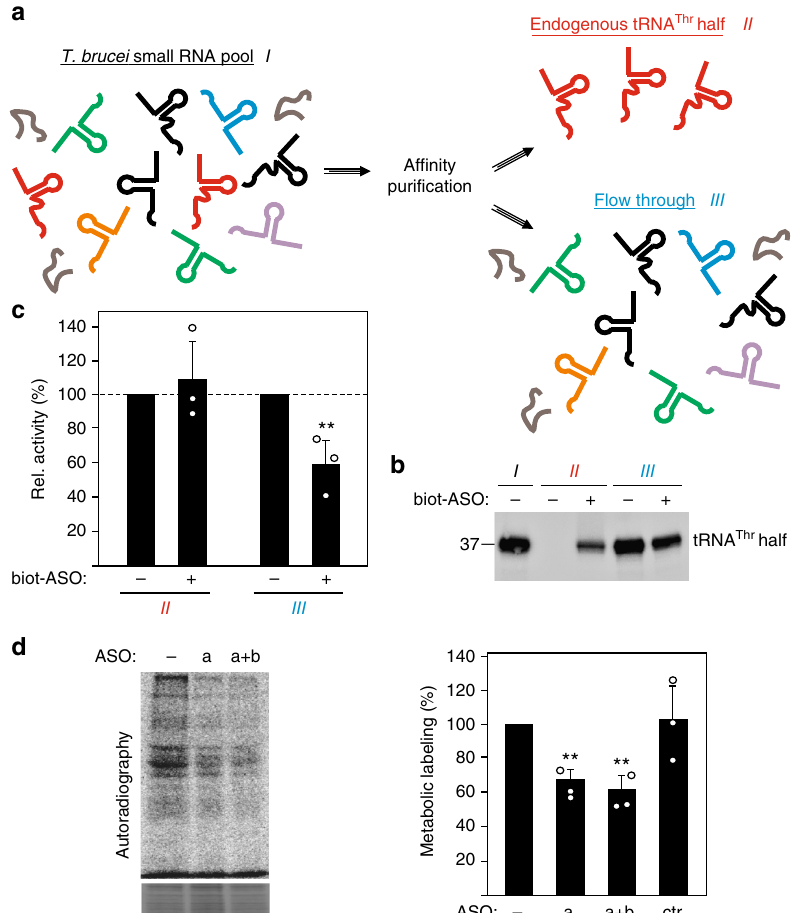
Fig. 6 Depletion of endogenous tRNA Thr 3 ′ halves alleviates the stimulatory effects during translation. a Scheme of the strategy used for af fi nity puri fi cation of the endogenous tRNA Thr 3 ′ half from the pool of small RNAs (size range between 30 – 40 nucleotides). As a control the same procedure was performed in the absence of a biotinylated antisense oligonucleotide (ASO). b Northern blot analysis of RNA extracted from the samples obtained after af fi nity puri fi cation showing the successful isolation of the tRNA Thr 3 ′ half (see also Supplementary Figure 10) when using the biotinylated ASO (fraction II + ) and its partial depletion from the corresponding fl ow through (compare fractions III, − and + ASO). A representative blot of in total two independent af fi nity puri fi cation experiments is shown. c Depletion of endogenous tRNA Thr 3 ′ halves from the pool of small RNAs results in reduced in vitro translation activities. The effects of RNA fractions obtained after af fi nity puri fi cation were tested on in vitro translation. Quanti fi cation (mean and standard deviation) shows the average of three independent experiments. d Chemically modi fi ed ASO complementary to the tRNA Thr 3 ′ half were electroporated into T. brucei cells and their effect on in vivo translation was investigated by metabolic labeling during stress recovery. The autoradiograph shows a representative SDS polyacrylamide gel in which metabolic labeling was performed in cells electroporated without an ASO ( − ) or cells electroporated with one (a) or two three independent metabolic labeling experiments is shown on the right. As speci fi city control metabolic labeling was performed also after electroporation of an analogous ASO without any sequence complementarity to the tRNA Thr 3 ′ half (ctr). Signi fi cance according to paired Student ’ s t -test: ** P ≤